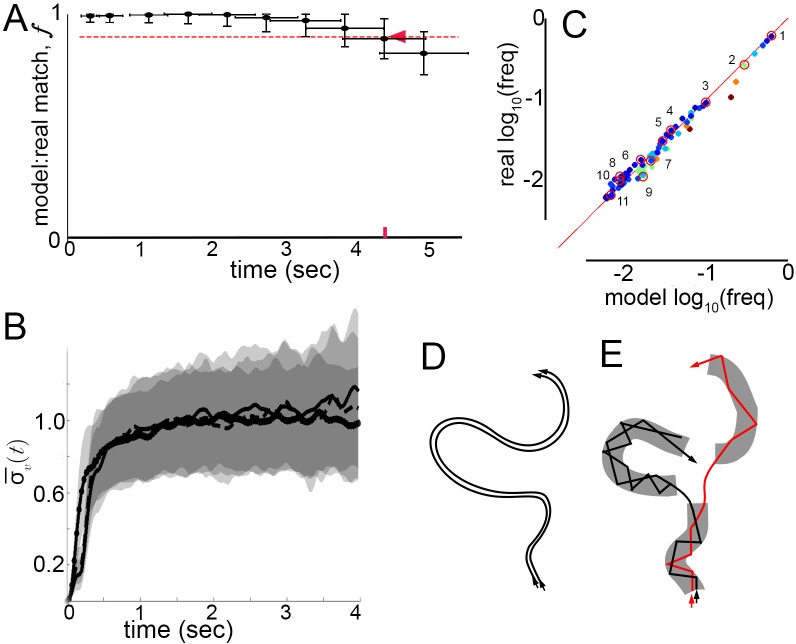
Model prediction and trajectory divergence over time.(A) Matched fraction (f) of mode sequences from real trajectories as a function of sequence length. Synthetic mode sequences were generated using the transition component of the model MM5. Red dashed line marks f=90%, red tick and arrow mark the sequence length when f first crosses below 90%. (B) Trajectory divergence in velocity space from randomly sampled small neighborhoods, without and with information about current mode identity. Two divergence curves from Figure 2D are replotted over a longer time scale: starting from neighborhoods anywhere in velocity space, and including all trajectories (dot-solid line), or including only trajectories that attained a turn peak 100 ms later(dashed line), or only those with a turn peak 100 ms later corresponding to a given mode (solid line). Dashed and solid lines overlap for their durations. Note the short ¯ plateau, and rise after approximately 200 ms. (C) Predicted versus actual log-frequency of all mode sequences above measurement noise, up to trajectories that include 17 consecutive modes, covering 4.3 s. Markers are colored by sequence length, from shortest (2-mer, dark blue) to longest (17-mer, dark red). R=1.00,n=60,p≪0.001; Sampling error cutoff is at freq < 12(2.58N−12), N = number of sequences in each condition. Ten of these sequences (#2–11) were randomly selected for display in Figure 7—figure supplement 1, plus the most common sequence (#1). (D) Illustration of velocity trajectories specified by a stable dynamical system. Two trajectories starting from similar velocities (arrowheads, bottom), follow similar paths over time that show little divergence some time later (arrowheads, top). (E) Illustration of mode structure and transitions in velocity space. Trajectories from a small region of velocity phase space (black and red arrows) display bounded divergence for the duration of a mode (gray area) but display approximately no memory of past behavior at transitions (gaps between gray regions) beyond their current mode. Note divergence in the course of mode traversal may lead to path scrambling inside modes (jagged lines).